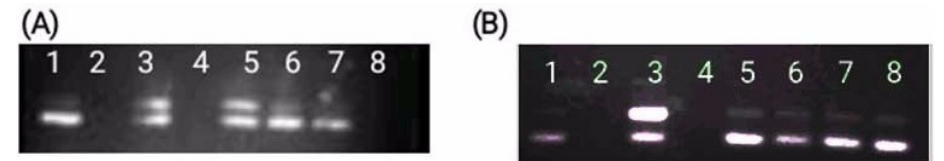
Figure 4. Protection to plasmid DNA pUC18 against oxidative damage. Gel electrophoresis pattern of pUC18 plasmid DNA after induction of oxidative damage in the presence or absence of different concentrations of aqueous and methanolic extracts of A. catechu . ( A ) Oxidatively damaged DNA in presence of aqueous extracts of Acacia catechu Lane 1: control pUC18 DNA, lane 3: oxidatively damaged DNA; lane 5: oxidatively damaged DNA in the presence of 0.01% extract, lane 6: oxidatively damaged DNA in the presence of 0.05% extract, lane 7: oxidatively damaged DNA in the presence of 0.1% extract. ( B ) Oxidatively damaged DNA in presence of methanolic extracts of A. catechu Lane 1: control pUC18 DNA, lane 3: oxidatively damaged DNA; lane 5: oxidatively damaged DNA in the presence of 0.01% extract, lanes 6: oxidatively damaged DNA in the presence of 0.05% extract, lane 7: oxidatively damaged DNA in the presence of 0.1% extract, lanes 8: oxidatively damaged DNA in the presence of 0.5% extract.